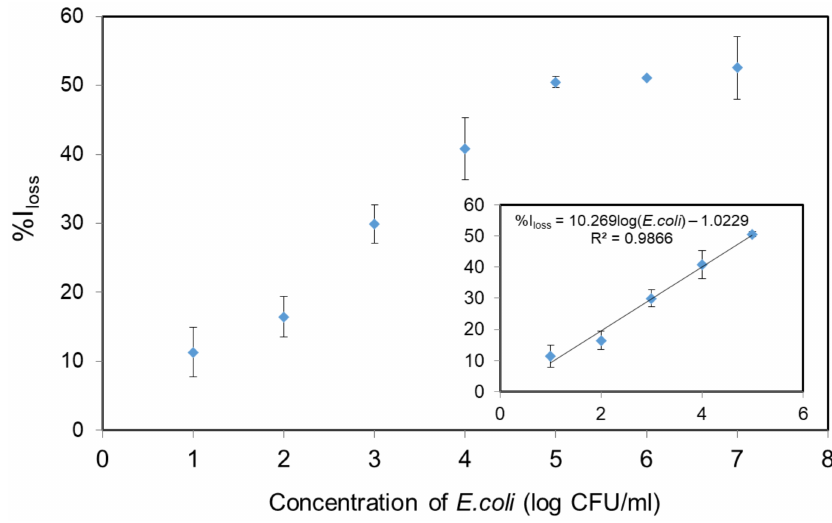
Figure 5. The correlation between % I loss of SNP-RB at 580 nm and E. coli concentrations after 15 min incubation. The inset shows the linear relationship over the range of 10–10 5 CFU/mL.